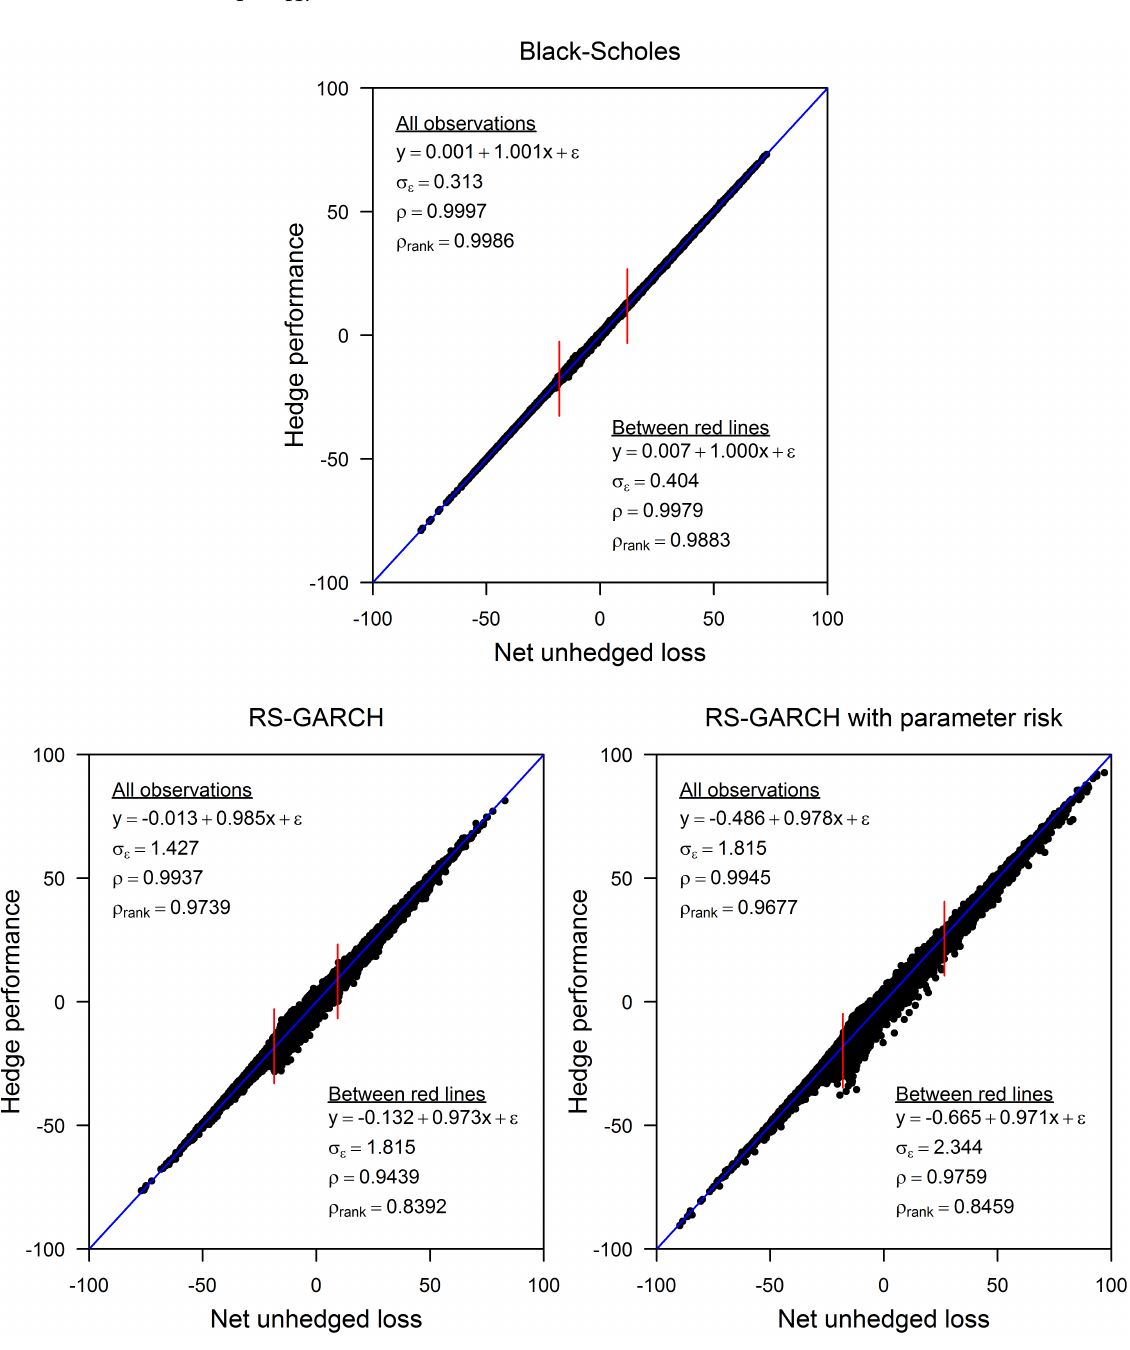
Figure 1. Relationship between the hedge performance and the net unhedged loss based on Figure 1 – Relationship between the hedge performance and the net unhedged loss based on 100,000 daily scenarios projected with the Black–Scholes model ( top panel ), the RS-GARCH model 100,000 daily scenarios projected with the Black-Scholes model (top panel), the RS-GARCH ( bottom-left panel ) and the RS-GARCH model with parameter risk ( bottom-right panel ). model (bottom-left panel) and the RS-GARCH model with parameter risk (bottom-right panel). The signs of hedging ineffectiveness observed under model uncertainty can be im- portant because by hedging the net liability, the insurer protects himself against losses at the cost of limiting their upside potential. In fact, hedging can be viewed as a tool resent the strength of the relationship between the hedge performance and the net unhedged loss